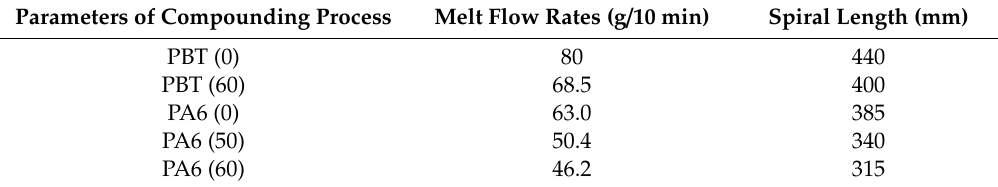
Table 4. Flow characteristics of PA6 / PBT / Al 2 O 3 composites with di ff erent weight ratios.